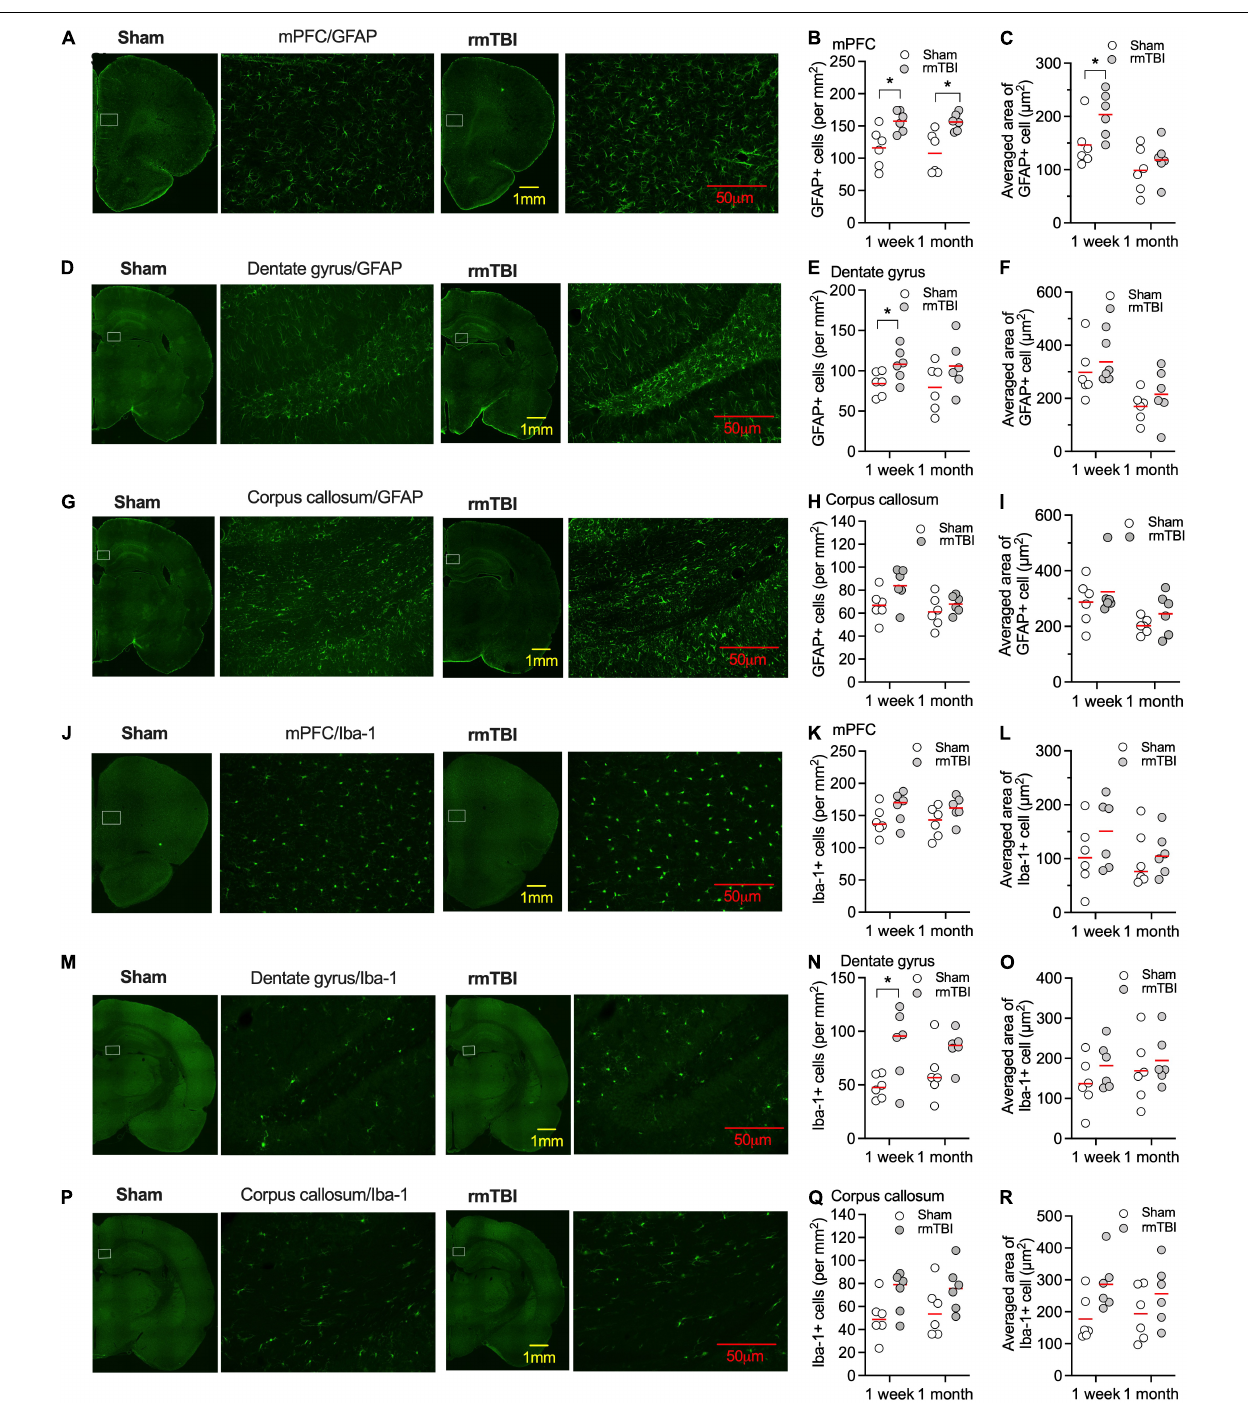
Frontiers in Cellular Neuroscience |